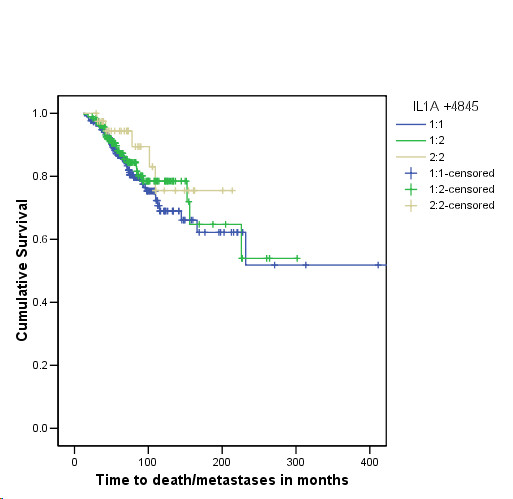
shows the time to death or metastases in invasive breast cancer for the genotypes of the IL1A +4845 polymorphism. Log Rank test statistic = 1.52; df = 2; p = 0.47 (n = 482).